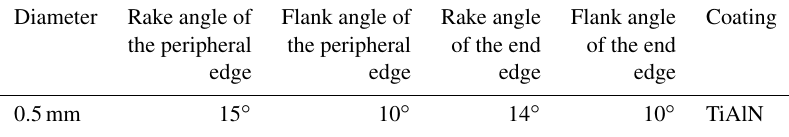
Table 2. Parameters of the cutting